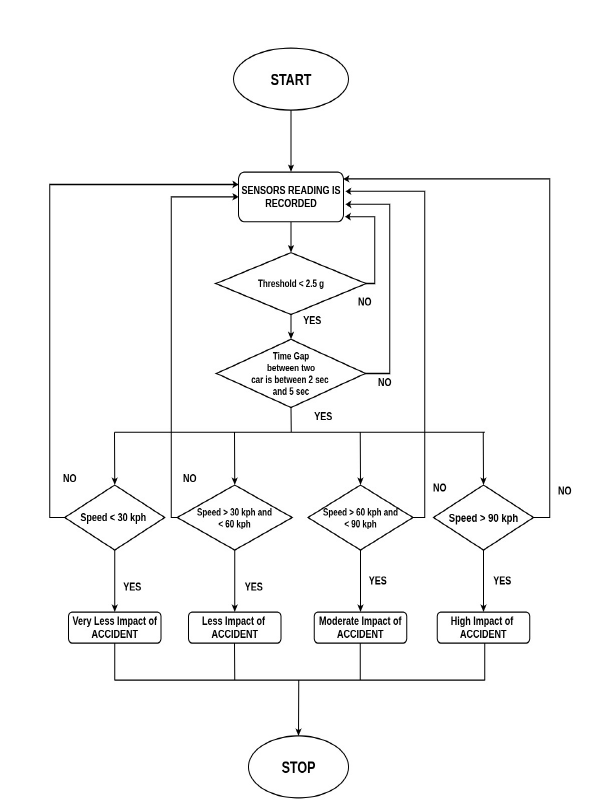
Figure 12. Working flow